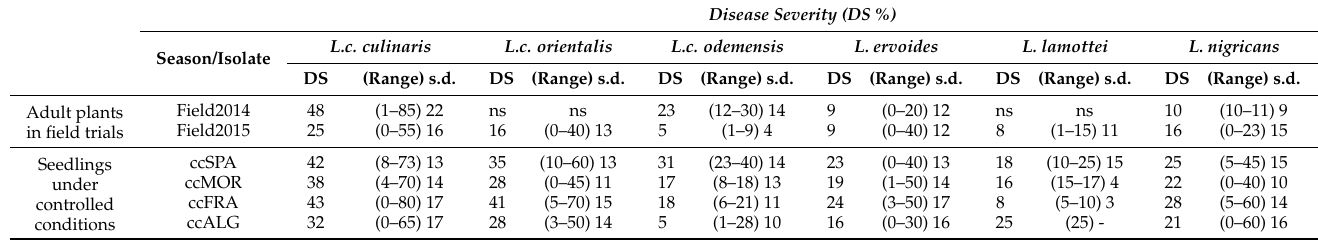
Table 2. Average and range of DS (%) observed at each trial, grouped by Lens species. Field2014 = adult plants in the field 2014; Field2015 = adult plants in the field 2015; ccSPA = seedlings under controlled conditions inoculated with isolate SPA; ccMOR = seedlings under controlled conditions inoculated with isolate MOR; ccFRA = seedlings under controlled conditions inoculated with isolate FRA; ccALG = seedlings under controlled conditions inoculated with isolate ALG; s.d. = standard deviation; ns: not studied.